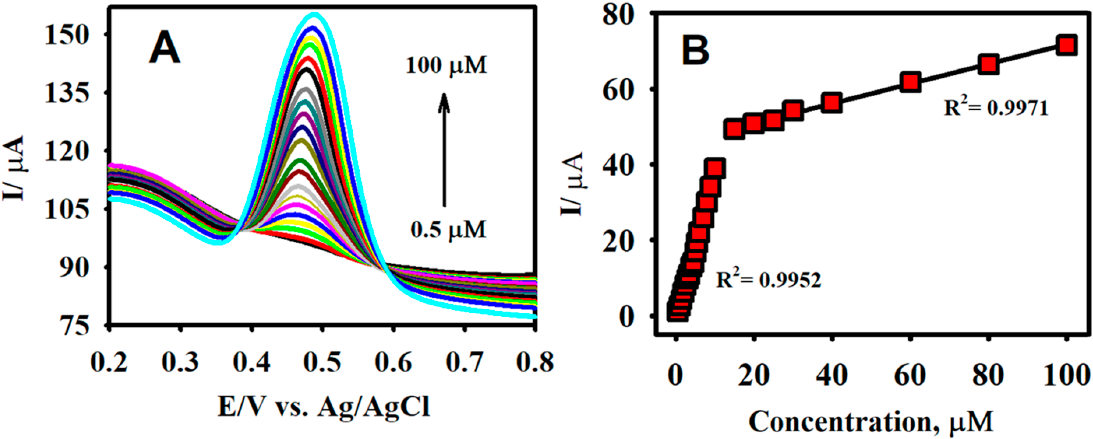
Figure 6. The CV responses of F-GO/GCE for the oxidation/reduction of CA at different concentrations, ranging from 10.0 to 70.0 μ M ( A ) and the corresponding plots of the anodic/cathodic peak current vs. the concentration of CA ( B ) in a 0.1 M B-R buffer solution pH 2.65, at a scan rate of 50 mV s − 1 .